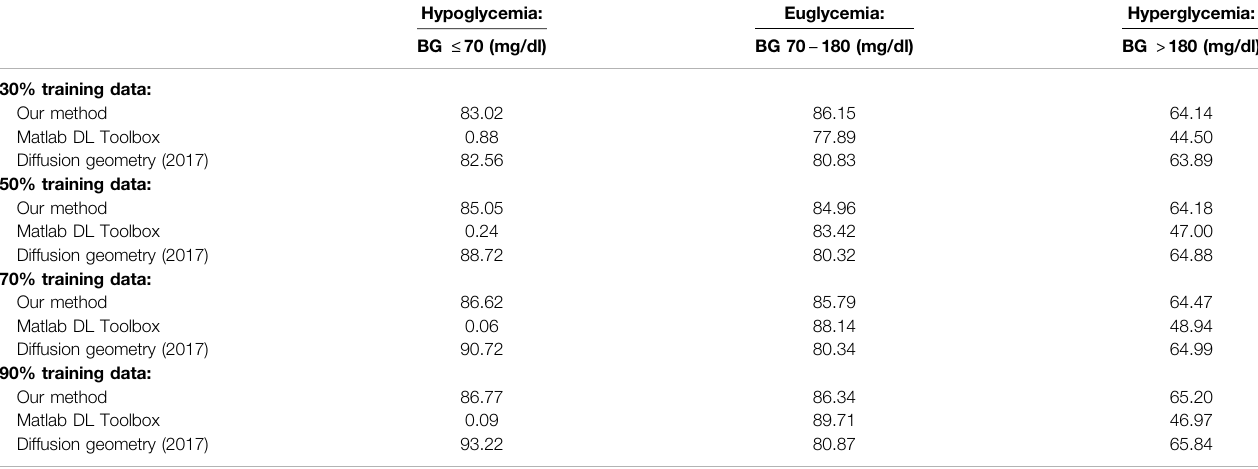
TABLE 5 | Percentage accurate predictions for different training set sizes and a 30 min prediction horizon on dataset D